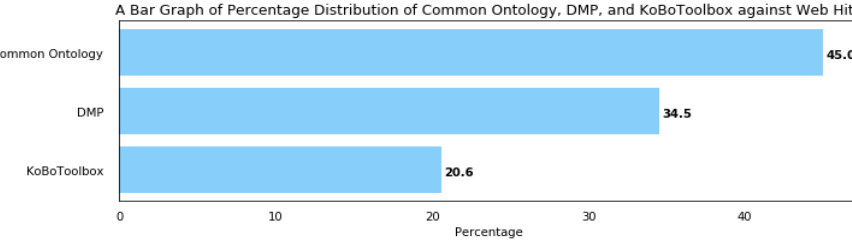
Figure 14. Common ontology, DMP, and KoBoToolbox against web hits.